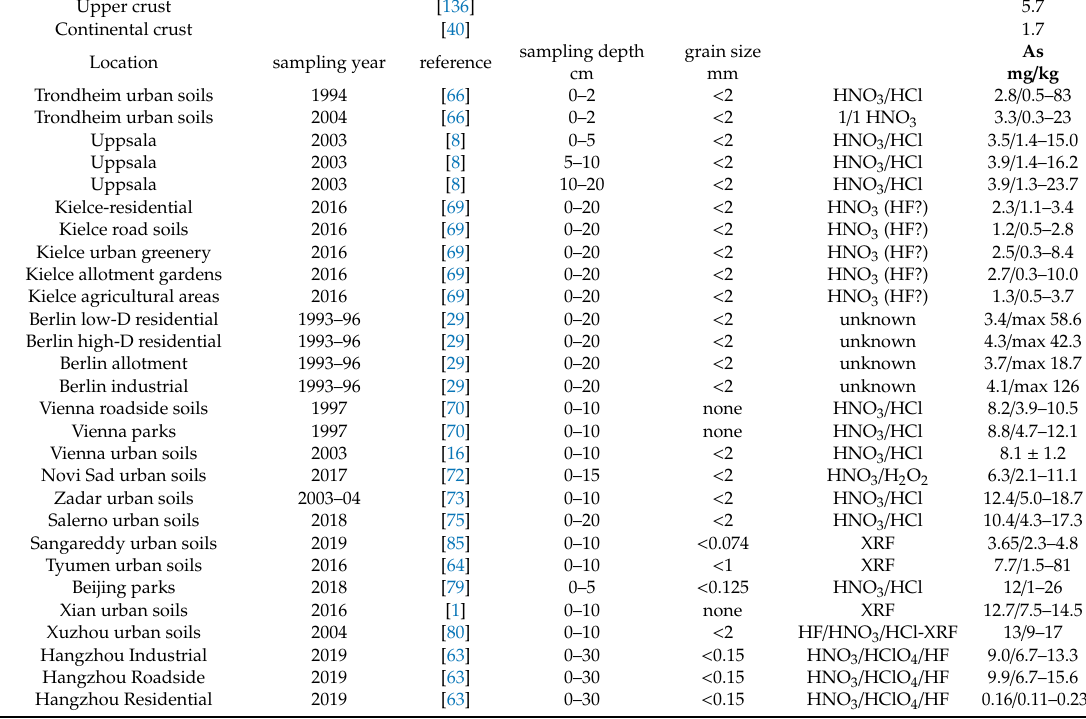
Table A6. Arsenic in urban